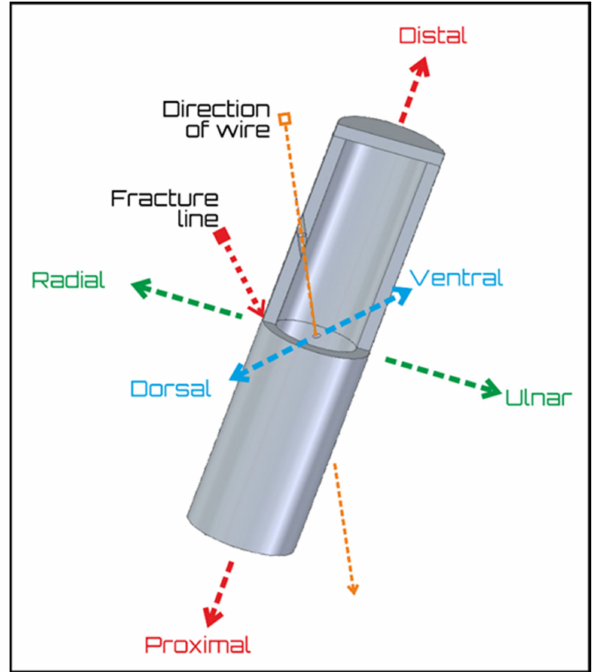
Figure 1. The fitted base on the bone model. The arrows define the anatomical directions, which were established in full accordance to medical terminology, including the direction of the wire and the fracture